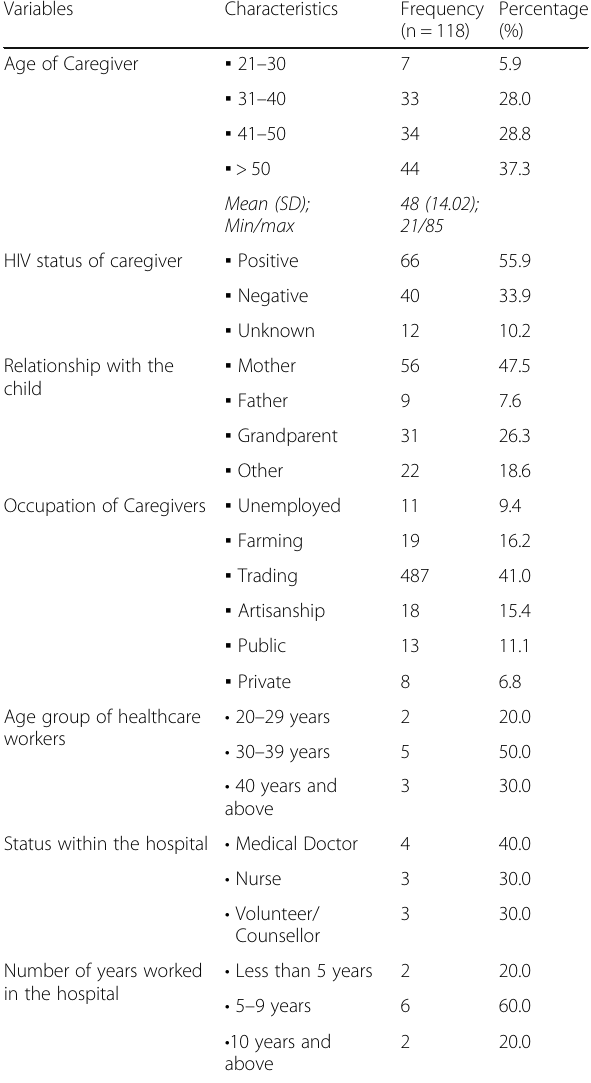
Table 1 Socio-demographic characteristic of caregivers and Healthcare workers